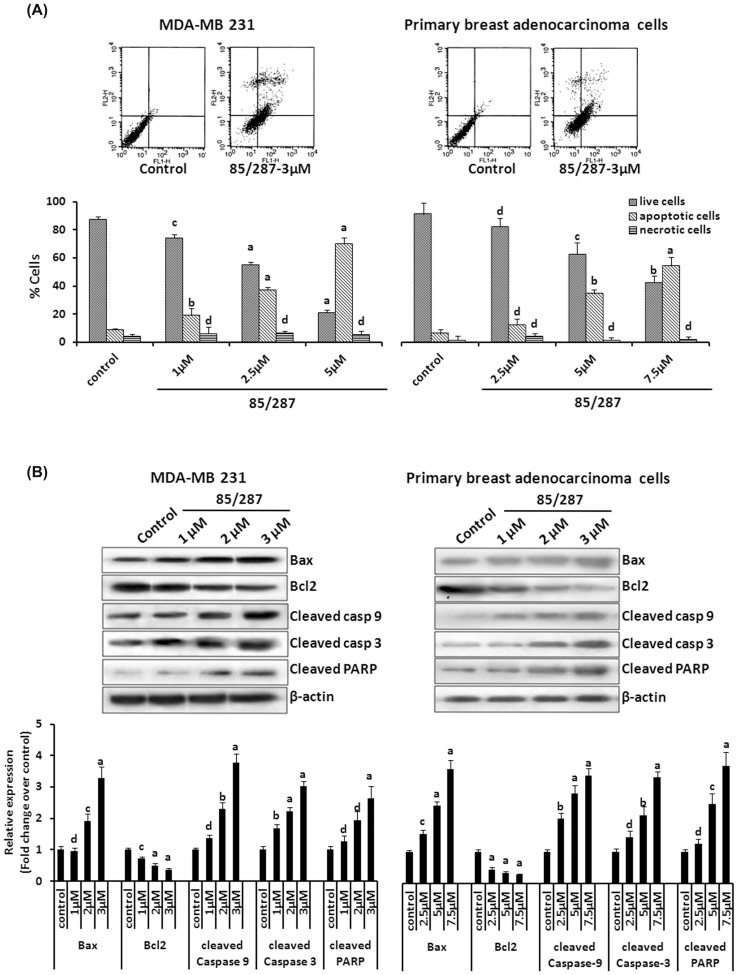
Analysis of apoptosis in MDA-MB 231 and primary breast adenocarcinoma cells.(A) Cells treated with vehicle and CDRI-85/287 were analyzed by flow cytometry of annexin-V/PI stained cells after 48h culture. AV+/PI− - intact cells; AV−/PI+ -nonviable/necrotic cells; AV+/PI− and AV+/PI+ - apoptotic cells. Representative images are shown in the upper panel and the percentage of cell fraction with SEM based on three independent experiments is shown in the lower panel. p values are a-p<0.001, b-p<0.01, c-p<0.05 and d-p>0.05 vs. control. (B) Western blot analysis to see the expression of pro- and anti- apoptotic proteins. MDA-MB 231 and primary breast cancer cells were treated with the indicated concentrations of compound for 48h, and 30 µg whole cell lysate in each lane was probed for the expression of different proteins using specific antibodies. β-actin was used as a control to correct for loading. Representative blots are shown in the upper panel and densitometric quantitation of protein expression levels are shown as fold changes in the lower panel. Results are expressed as mean ± SEM, n = 3. p values are a-p<0.001, b<0.01, c-p<0.05 and d-p>0.05 vs. control.